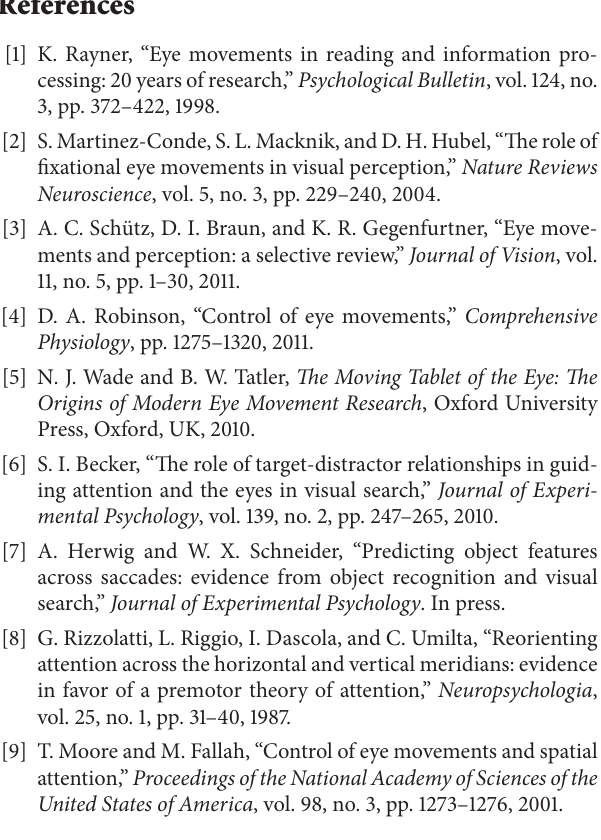
from cognitive science over applied psychology to clinical psychology and